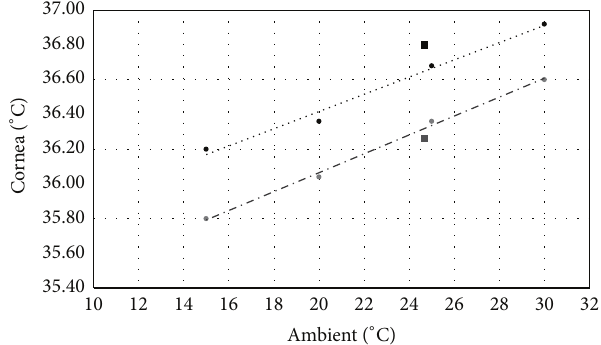
Figure 4: Theoretical temperature values extrapolated from Karam- patzakis’s physical model, relating the ambient temperature ( 𝑥 - axis) to the average corneal surface temperature ( 𝑦 -axis) with open eyelids (closed, grey circles, and dotted line), or after one hour of CET (closed, black circles, and continuous line). The closed squares represent the actual measured values at an ambient temperature of 25 ∘ Cofaveragedcornealtemperaturesfortherightandlefteyeswith open eyelids (lower grey square), or after one hour of CET (upper black